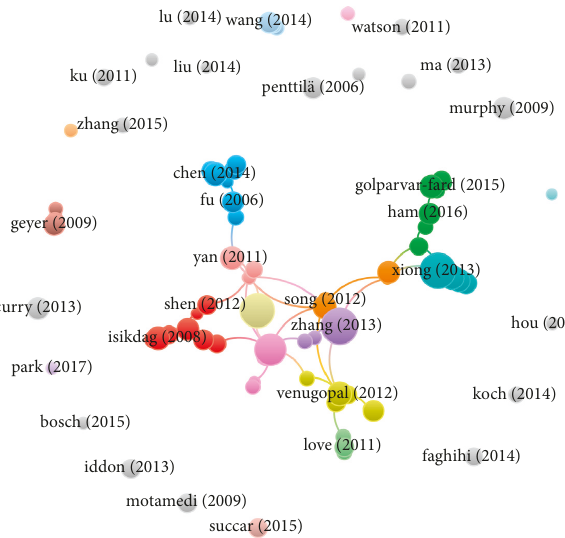
Figure 8: Citation network of articles.